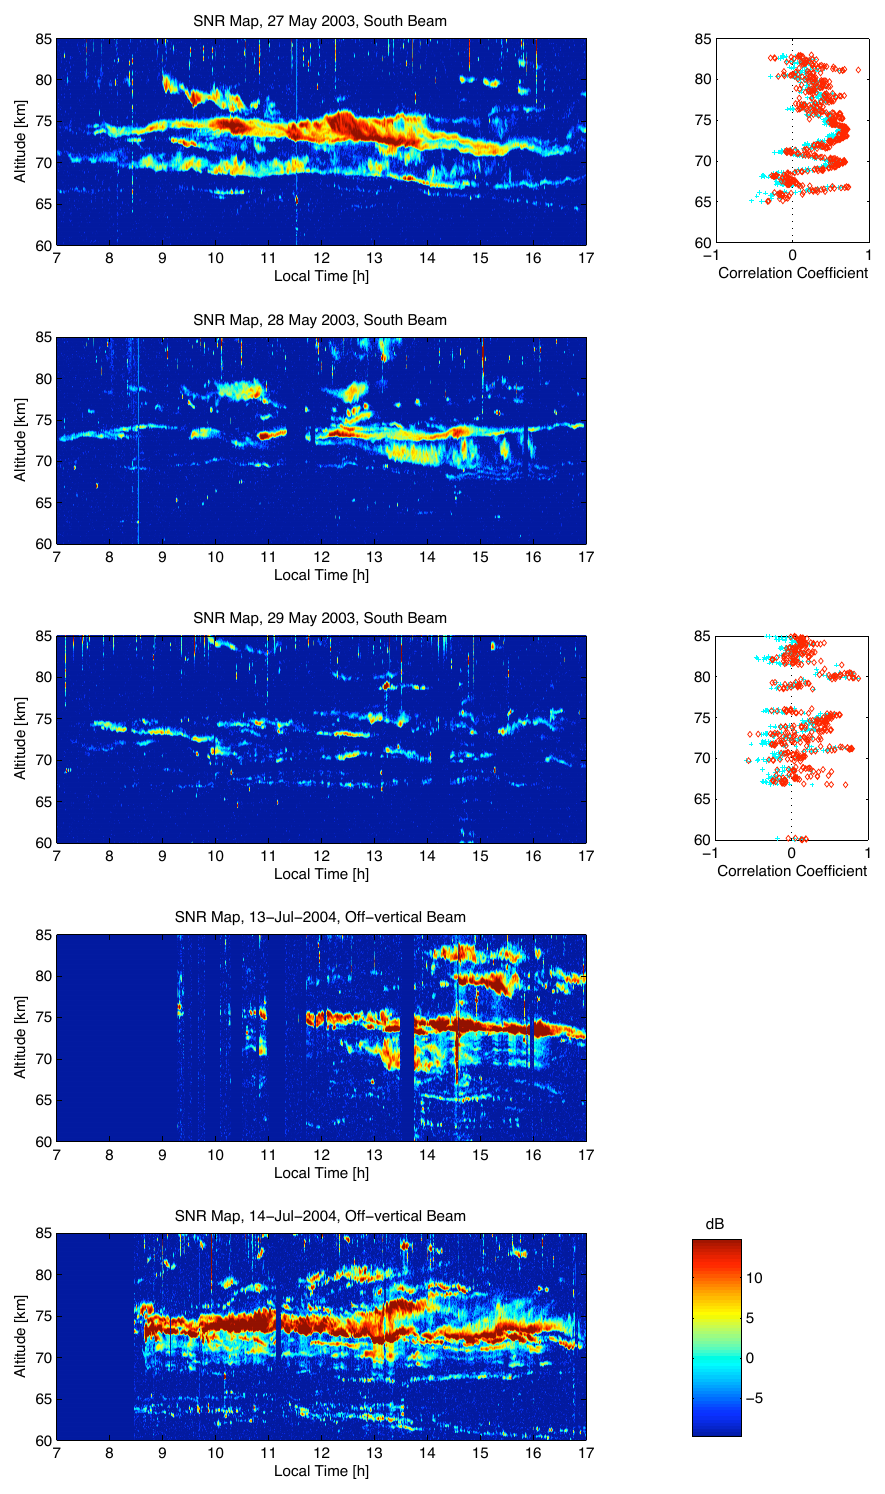
Fig. 4. SNR maps from May 2003 (south beam data) and July 2004 (off-vertical beam) observations. Height profiles shown to the right of top and middle panels correspond to spectral width versus echo power correlation coefficients.